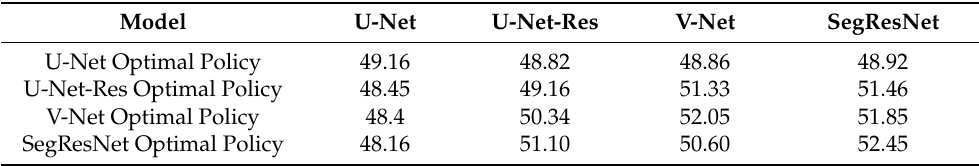
Table A4. BraTS transferability experiments showing the IoU test performance of neural networks trained using optimal policies found from the search with the other neural networks.